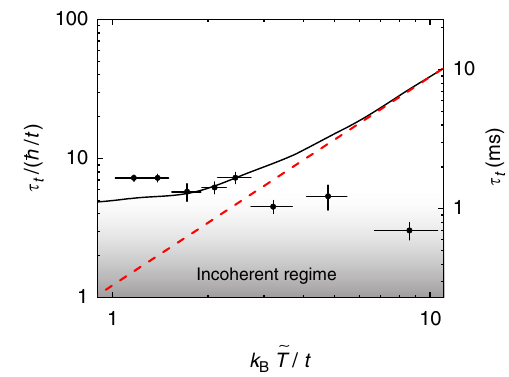
Fig. 3 Transport lifetime at varied temperature and fi xed interaction strength U / t = 2.3. A logarithmic scale is used to display the data. The lifetime τ t is shown in units of the tunneling time (left axis) and in ms (right axis). The slope from a linear fi t to the data (not shown) has a negative slope at greater than a 99.5% con fi dence level. The measurements are compared with a FGR weak-scattering calculation (black solid line) and a scaling prediction (red dashed line, which was fi xed to match the FGR result at the highest temperature point) in the Maxwell-Boltzmann limit. For the FGR calculation, N is fi xed to the average value from the data. The vertical error bars show the uncertainty in the fi t used to determine τ t , and the horizontal error bars display the uncertainty in T from time-of- fl ight